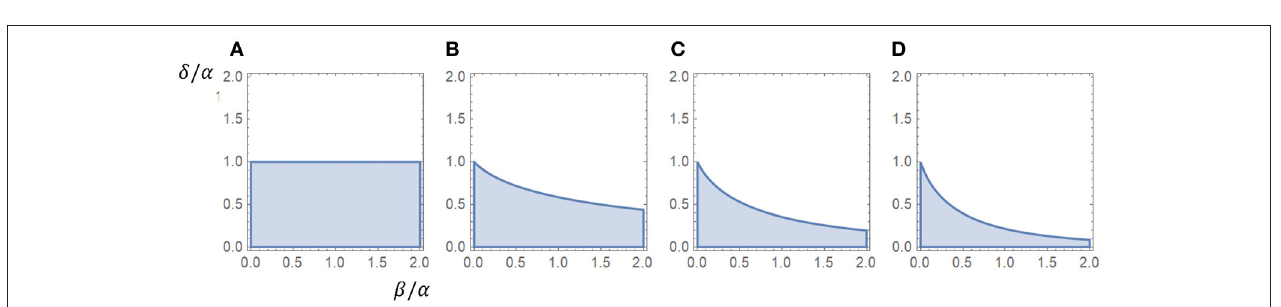
Frontiers in Cellular Neuroscience |